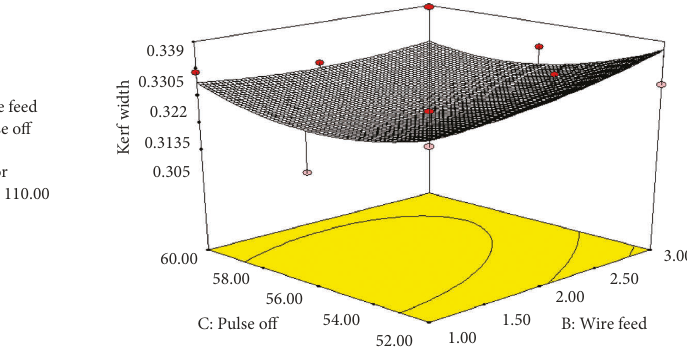
Figure 8: Effect on PT